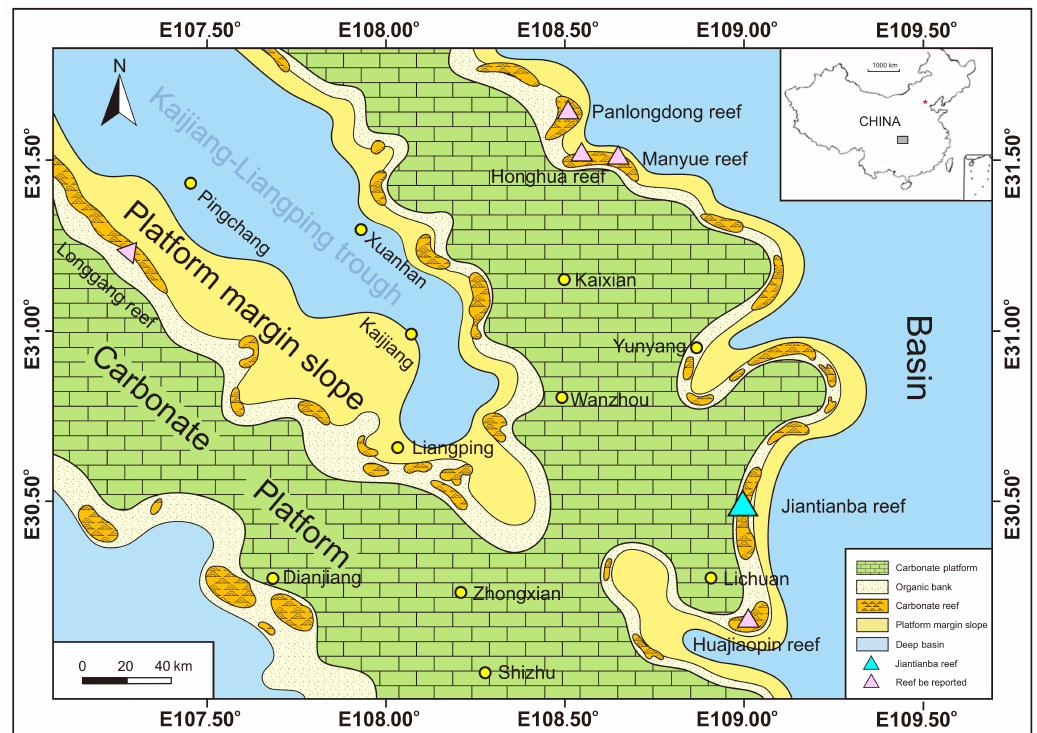
Figure 1. Paleogeography of the Late Permian Changhsingian stage in western Hubei area, south China. The Carbonate platform also belong to the northeastern part of the Sichuan basin. The detailed GPS location of Jiantianba reef is located at 30.4573 ◦ N; 109.0772 ◦ E. The figure is modified from He, Y. B.